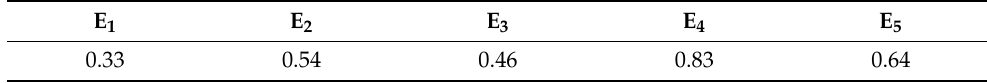
Table 9. Experts’ scores.